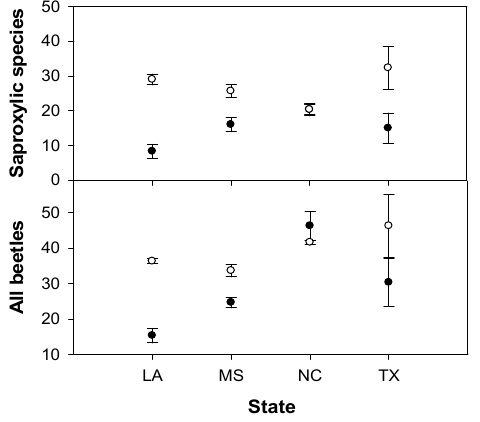
Figure 2. Mean ± SE ( n = 3) saproxylic (top) and total (bottom) beetle species richness in reference and dead wood plots (closed and open circles, respectively) by state in 1998.